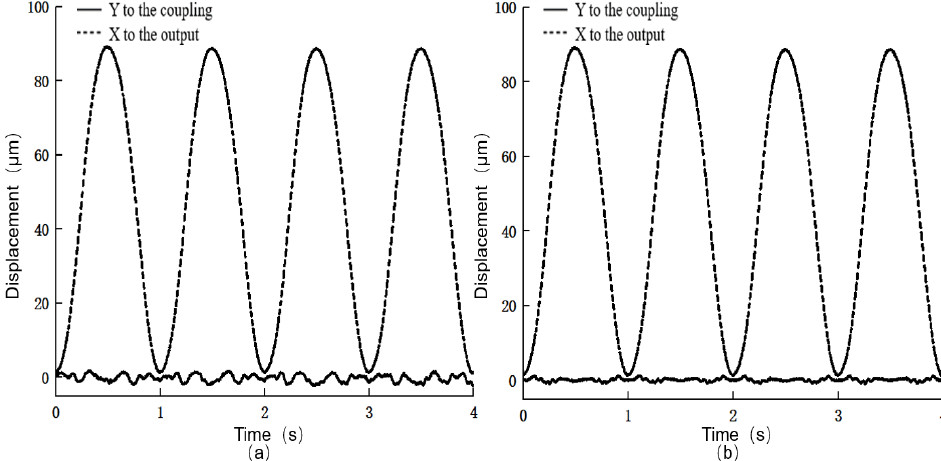
Figure 18. Comparison diagram before and after decoupling in the y direction: ( a ) before decoupling; ( b ) after decoupling.